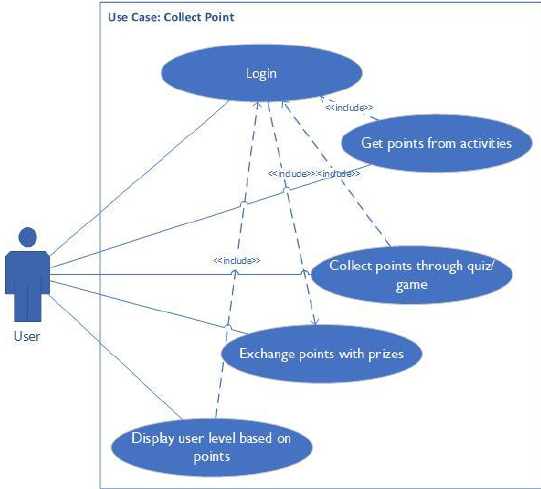
Fig. 4 Use Case Diagram of Collect Point